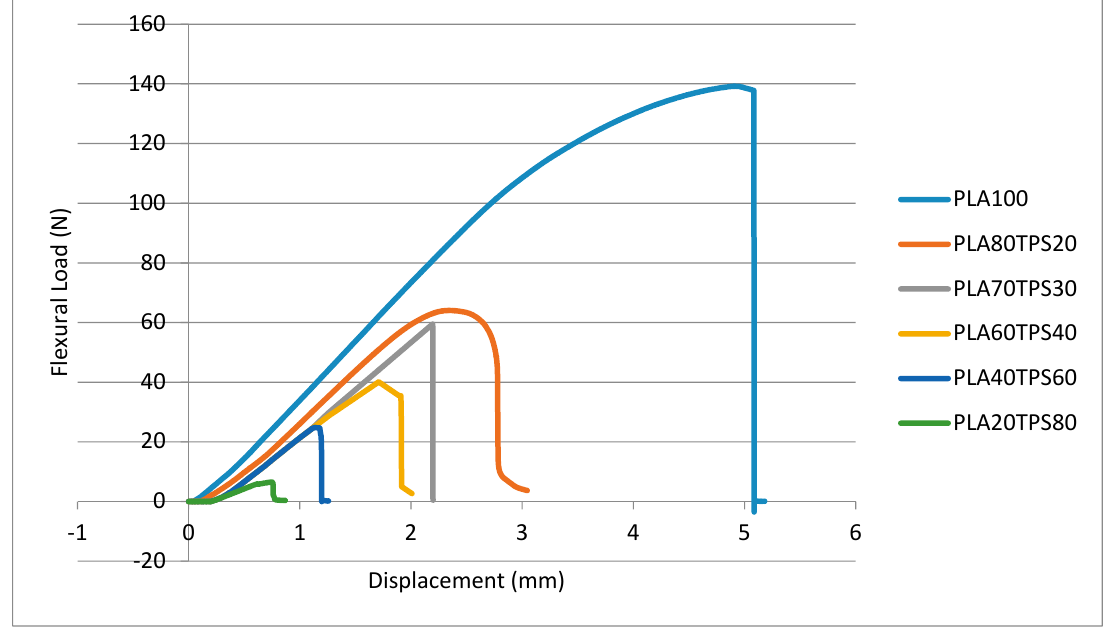
Figure 7. Flexural load–displacement curves of PLA100 and PLA/TPS blend bionanocomposites.